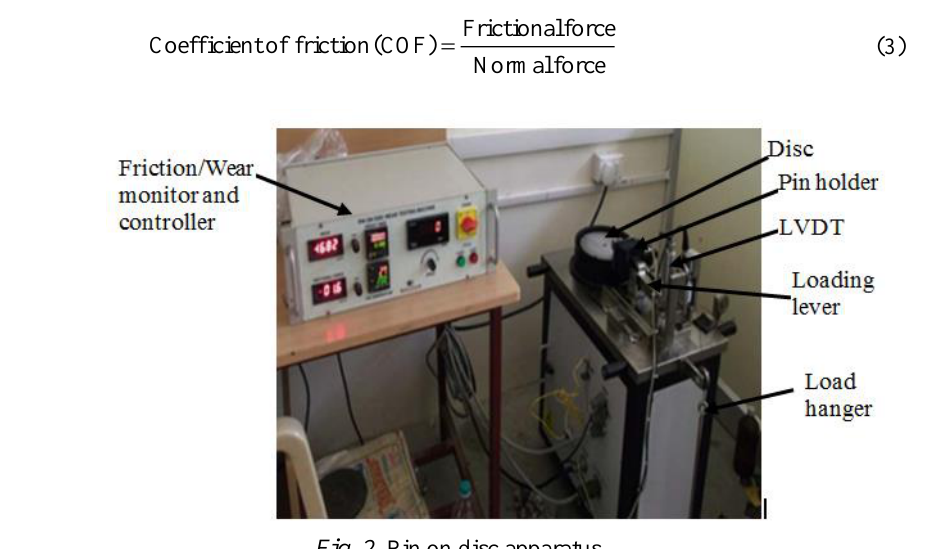
Fig. 2. Pin on disc apparatus. Table 3.Experimental plan and